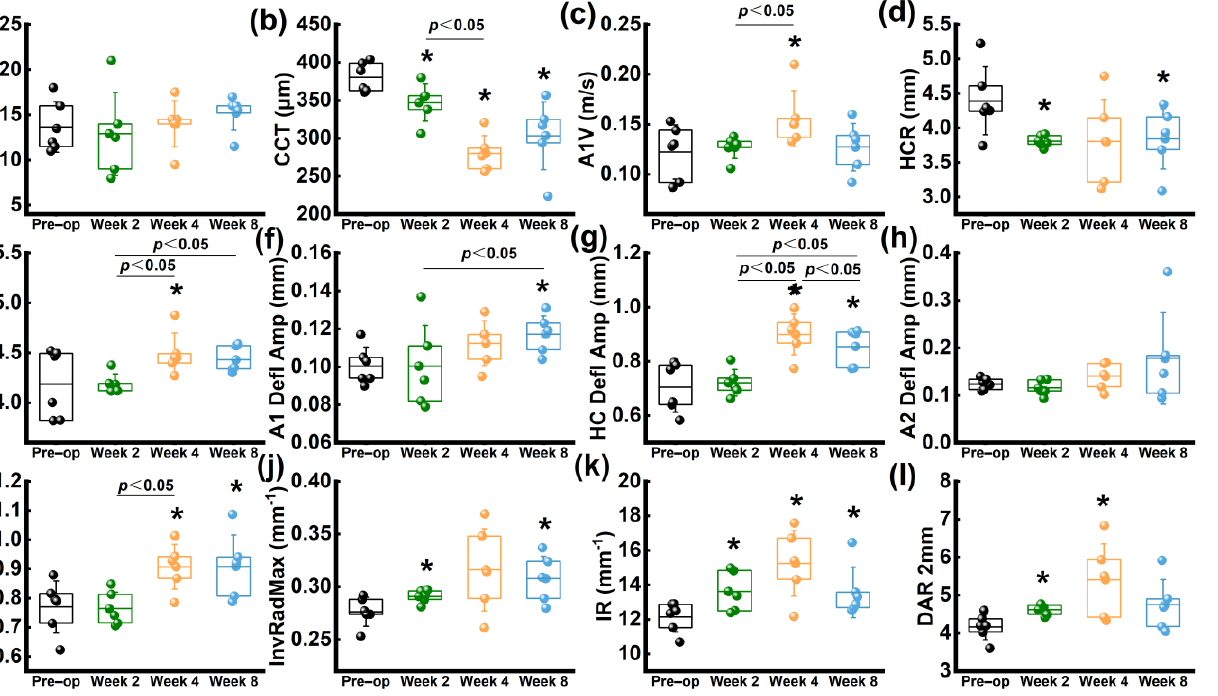
Figure 7. The parameters derived by Corvis ST. ( a ) IOP; ( b ) CCT; ( c ) A1V; ( d ) HCR; ( e ) HC−PD; ( f